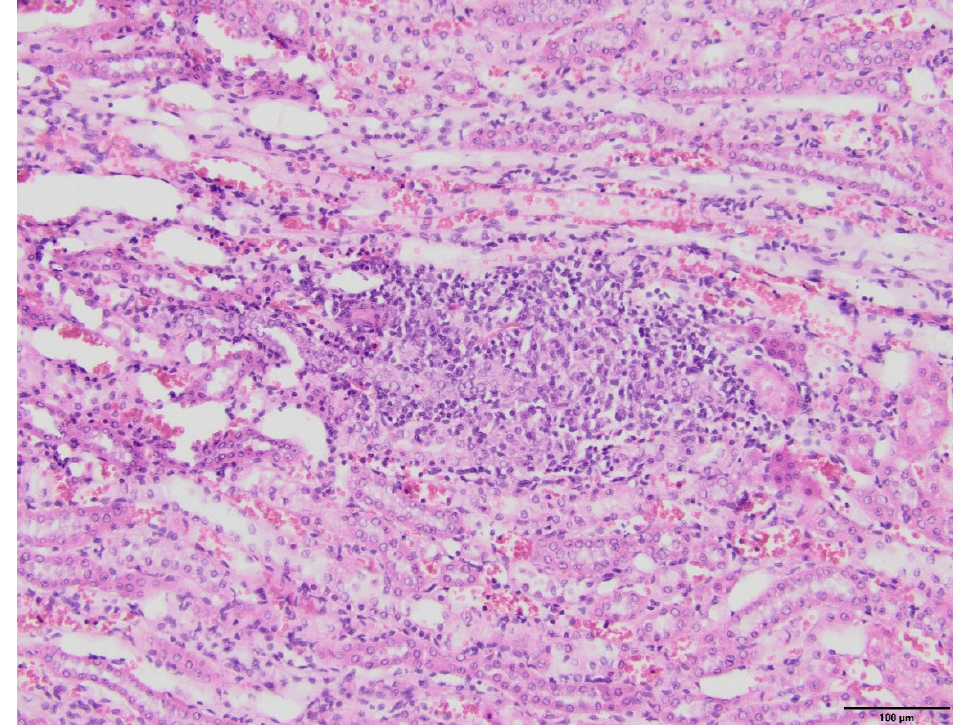
Figure 6. Pathological lesions in kidneys of rats on 60% FR diet (F60). Moderate lymphocytic infiltration of renal tubules and interstitium. (HE, magnification 20 × ).